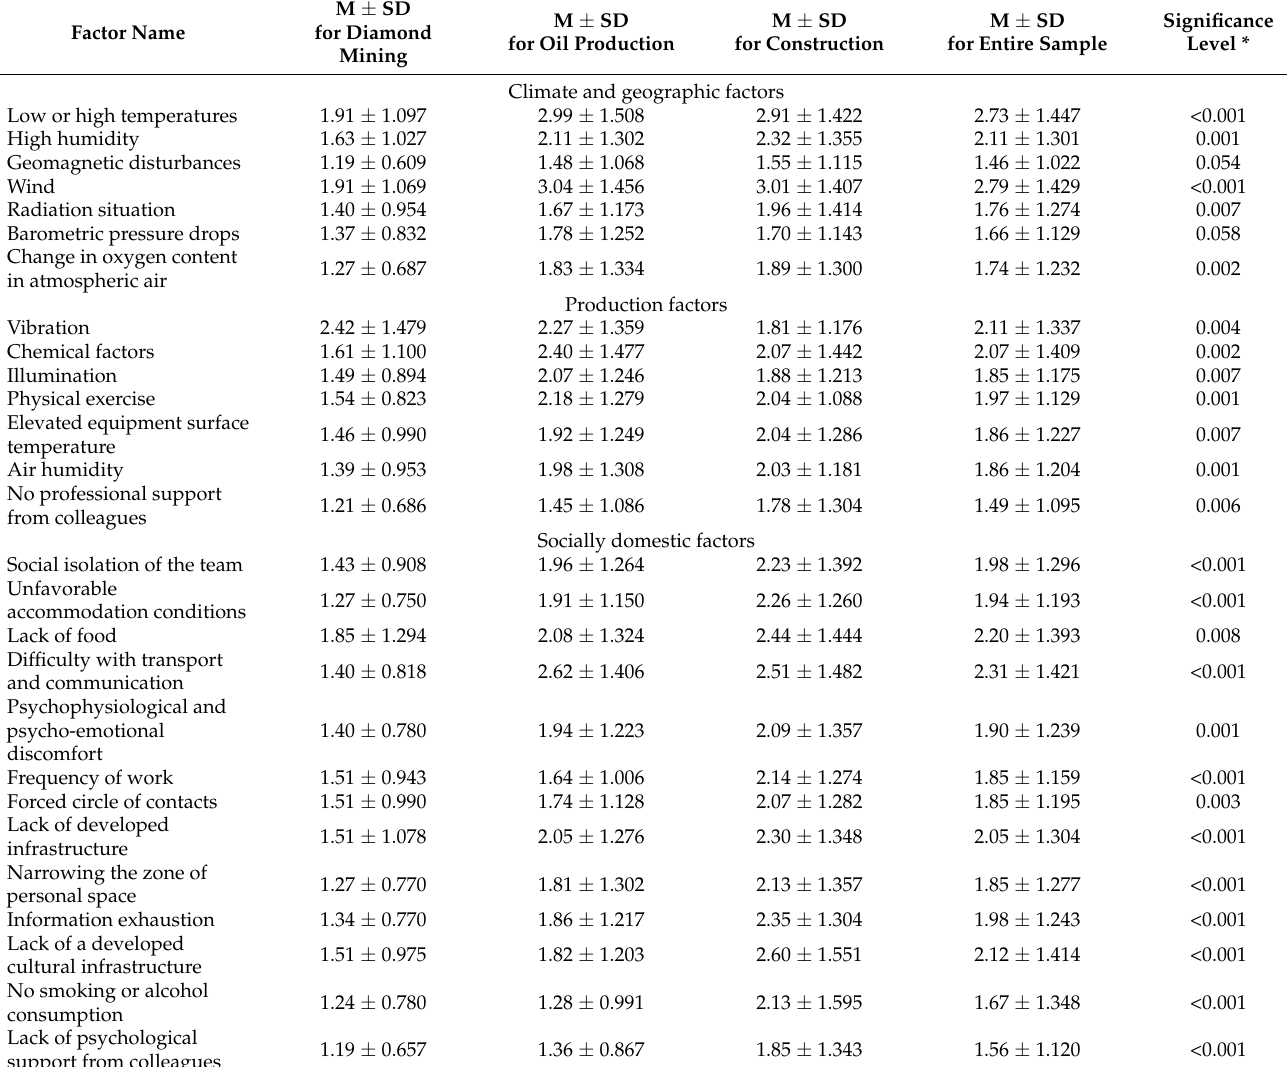
Table 5. Statistically significant differences according to univariate tests in the subjective assessment of the discomfort of climatic, geographical, production and social factors in FIFO personnel in various industries (on a five-point scale, where 5 is the most uncomfortable